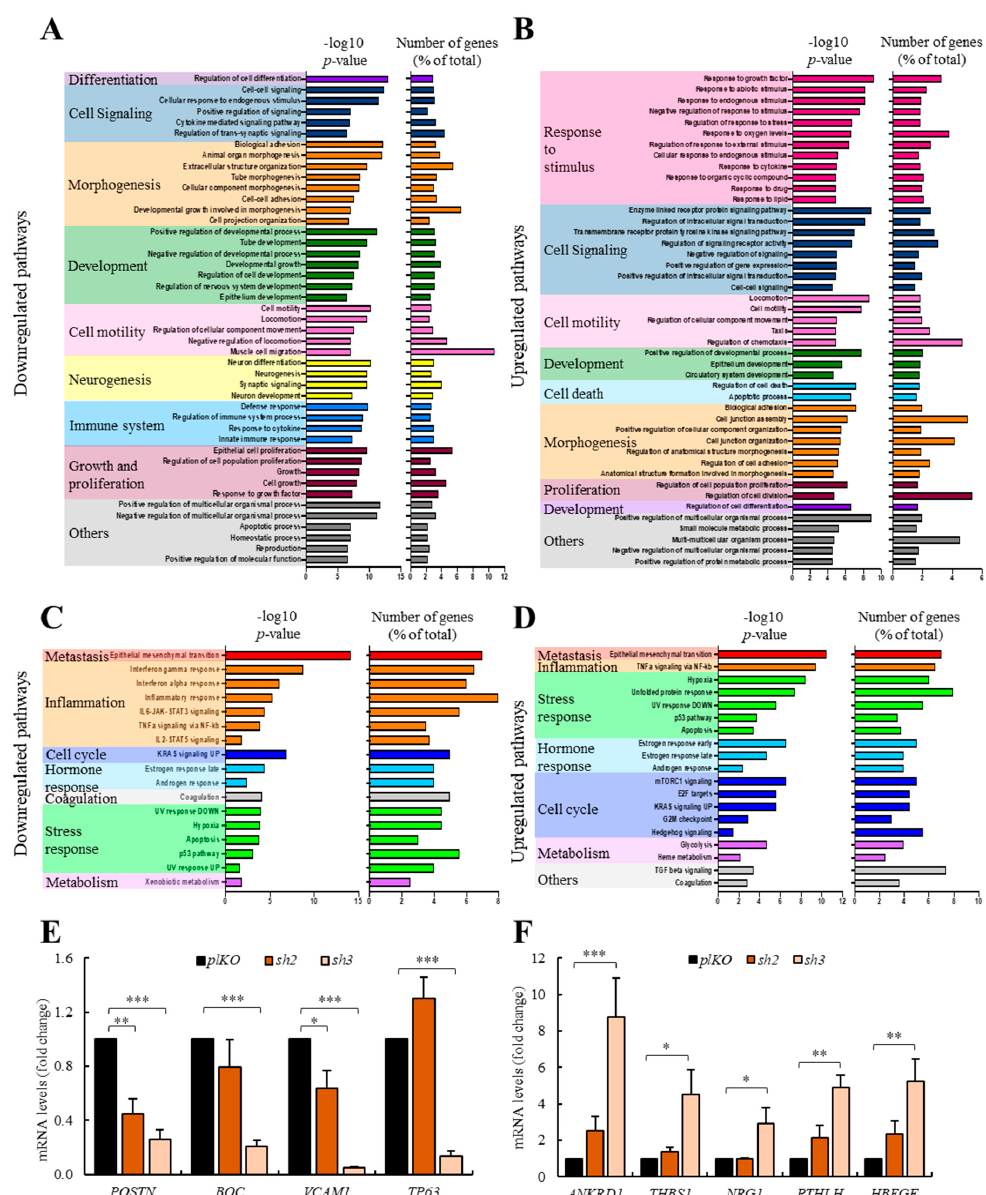
Figure 6. ERBB4 knock-down alters multiple pathways of medulloblastoma cells. ( A , B ) Downregulated and upregulated pathways in sh2 and sh3 DAOY cells compared with pLKO cells when performing a GO gene sets biological processes analysis of Clariom S microarray results. ( C , D ) Downregulated and upregulated pathways in sh2 and sh3 DAOY cells compared with pLKO cells when performing a hallmark gene sets analysis of Clariom S microarray results. The p -value and the percentage of genes deregulated in each pathway are represented in all figures. ( E,F ) mRNA levels of downregulated and upregulated genes in control ( pLKO ) and shERBB4 ( sh2 and sh3 ) DAOY cells ( n ≥ 3). * p ≤ 0.05; ** p ≤ 0.01; and *** p ≤